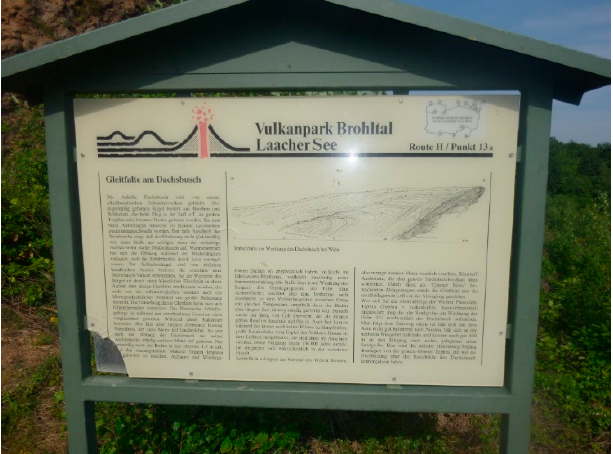
Figure 3. First generation of nature trail boards in the Eifel (Author 2011).